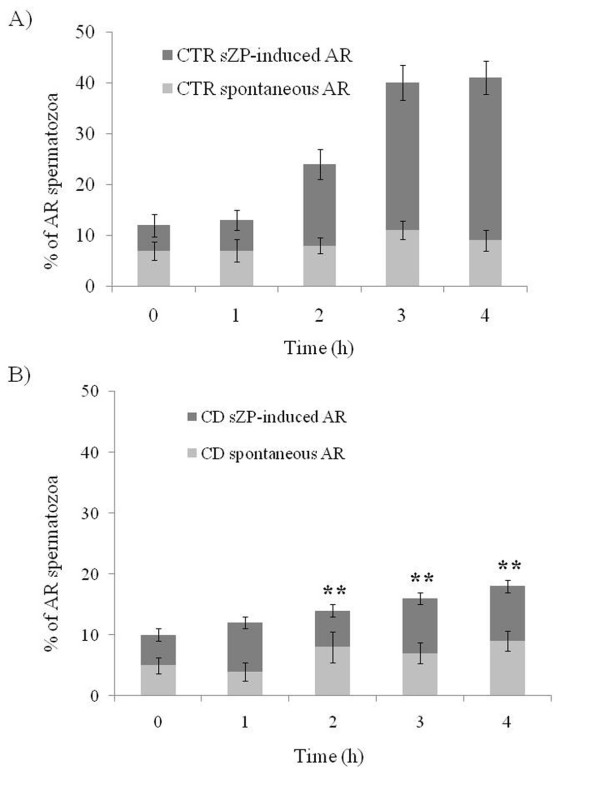
Histogram representing the percentage of spermatozoa undergoing spontaneous and sZP-induced AR in CTR (A) and CD (B) treated spermatozoa. Histograms showing the percentage of spermatozoa undergoing spontaneous (light gray) or sZP-induced (dark gray) AR in spermatozoa incubated under control conditions (panel A) or in the presence of CD (panel B). All the values are represented as mean ± SD. ** = p < 0.01 vs. CTR